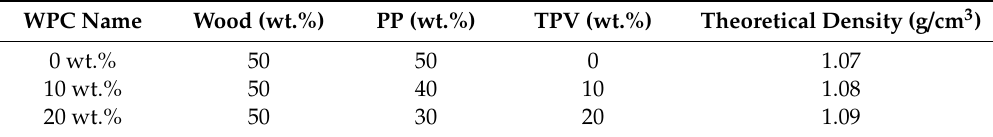
Table 1. Description of the Wood Polymer Composite (WPC)